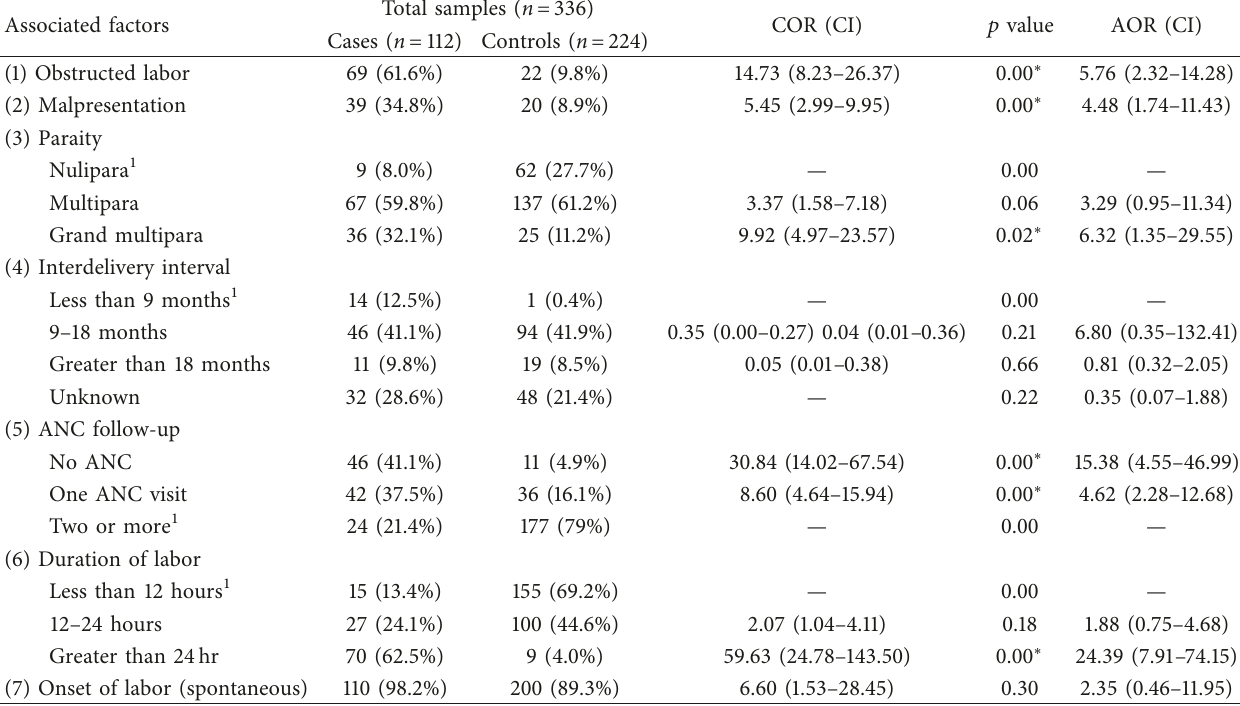
Table 3: Factors associated with uterine rupture at Shire General Hospital, North West Tigray, Ethiopia 2016. Associated